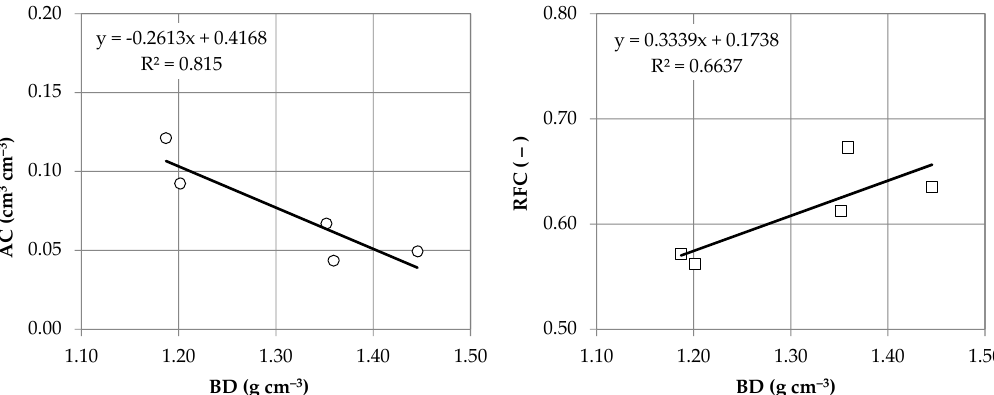
Figure 5. Relationships between mean values of air capacity (AC) and relative field capacity (RFC) as a function of soil bulk density (BD), corresponding to the five sites investigated.